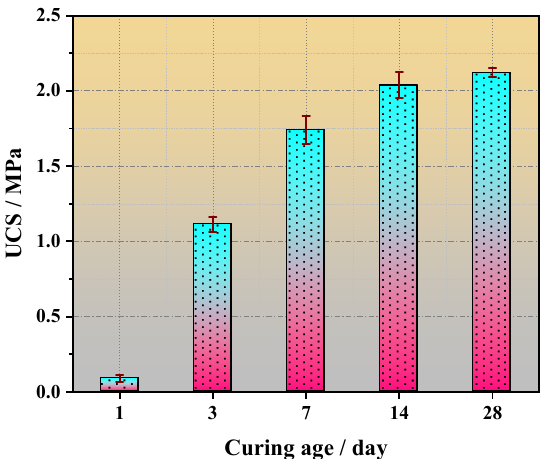
Figure 7. Variation in strength with curing age for the optimal mixture ratio of COSGB.